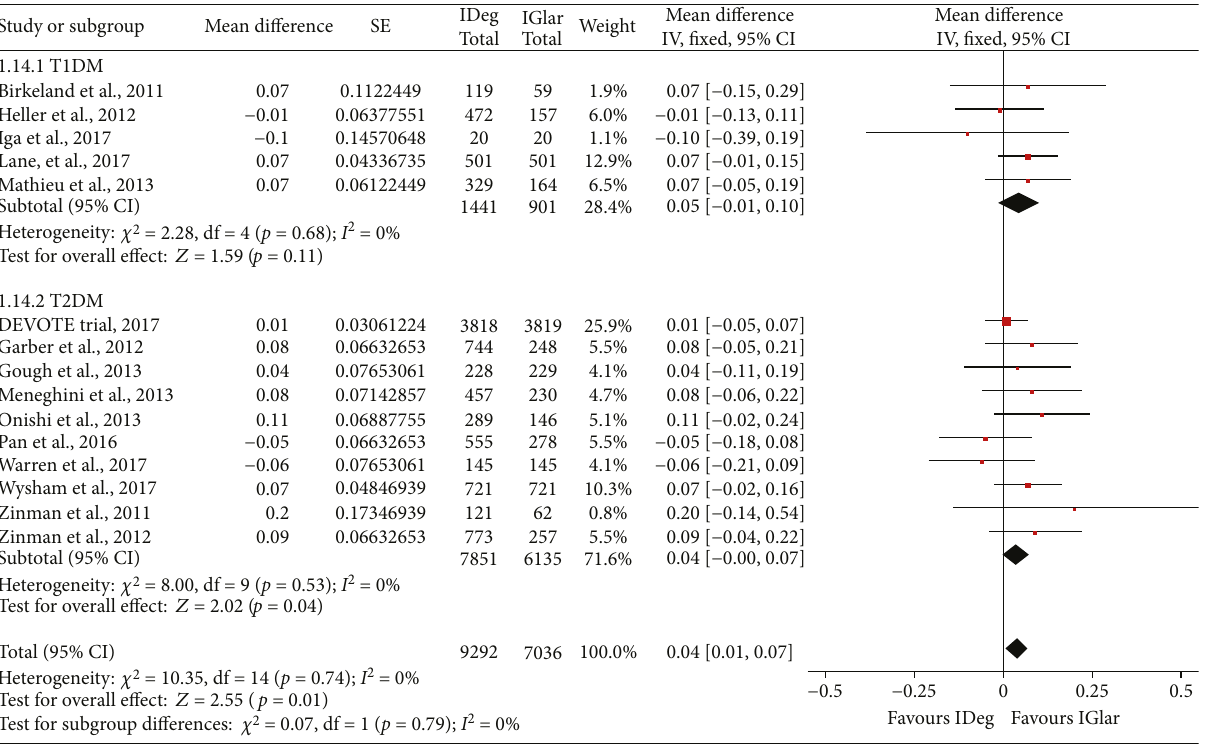
Figure 1: Mean di ff erence in the changes in the glycosylated hemoglobin (HbA1c) level between the IDeg and IGlar groups: